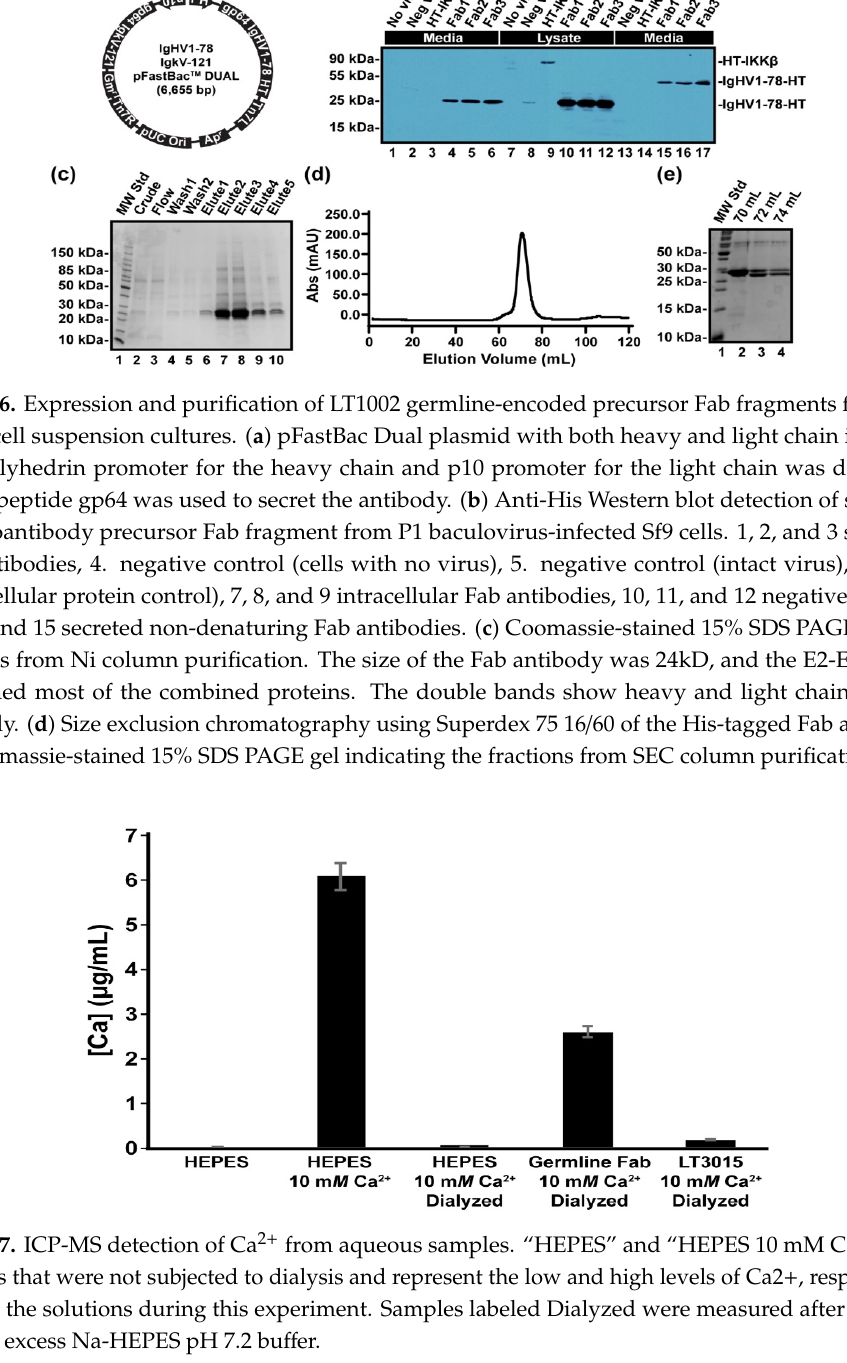
Figure 7. ICP-MS detection of Ca 2+ from aqueous samples. “HEPES” and “HEPES 10 mM Ca 2+ ” are samples that were not subjected to dialysis and represent the low and high levels of Ca2+, respectively, used in the solutions during this experiment. Samples labeled Dialyzed were measured after dialysis against excess Na-HEPES pH 7.2 buffer.